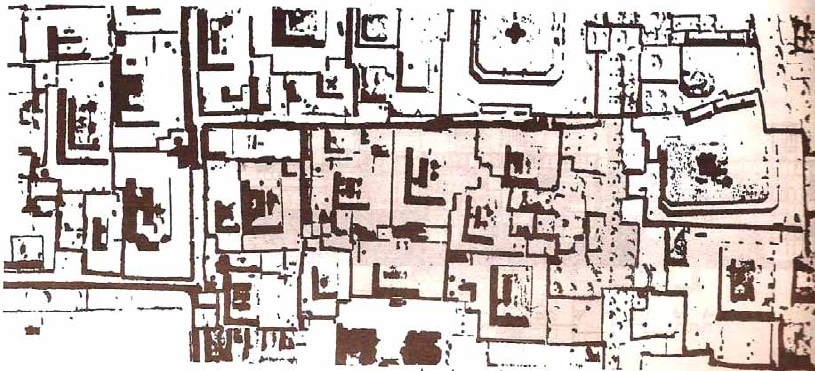
fig. 2c. a schematic diagram results from figures 2a and 2b which shows the role of courtyards as an ordered geometry in identifying free geometry of urban texture